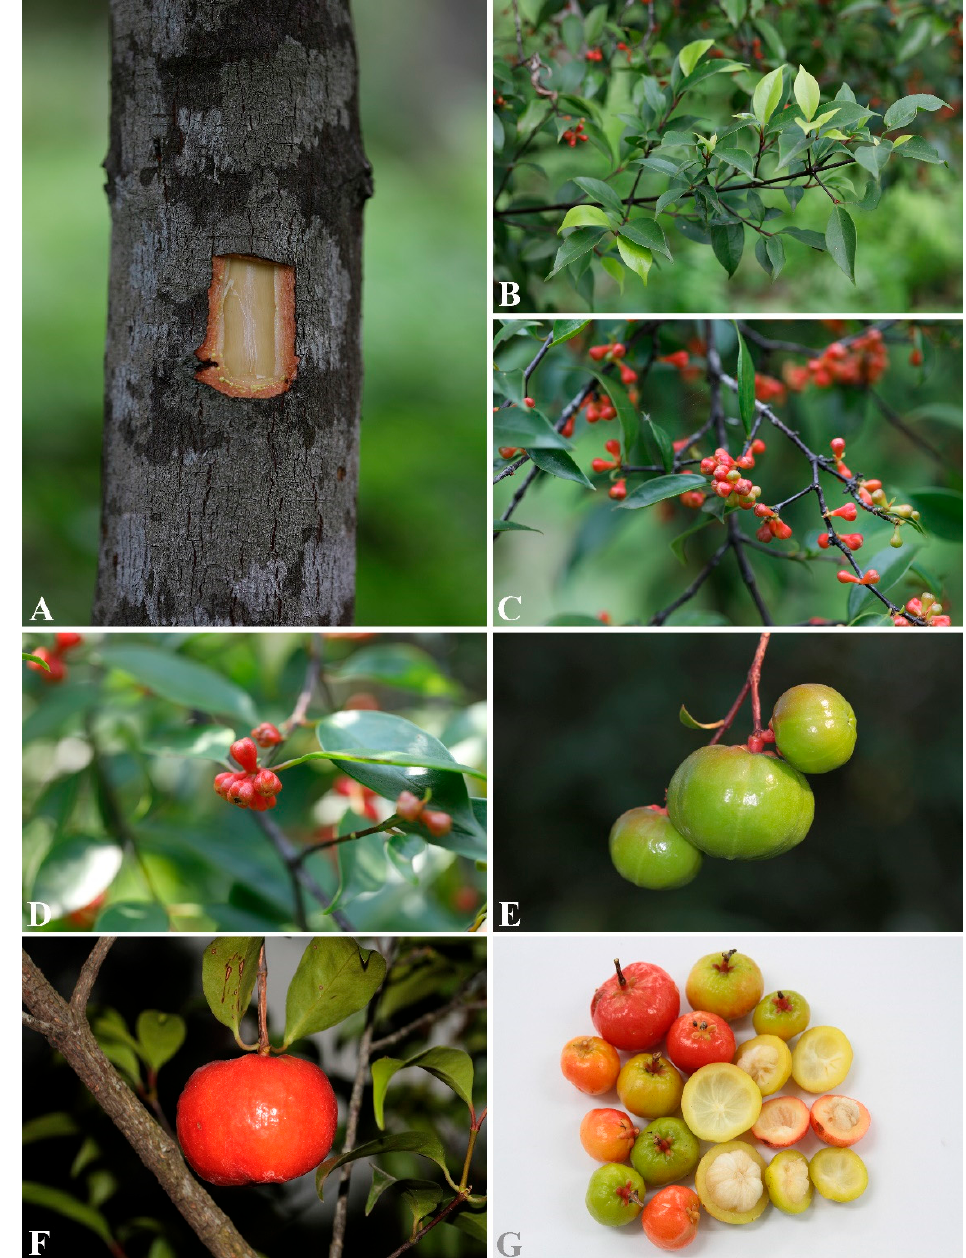
Figure 7. Garcinia lanceifolia : ( A ) stem, outer bark and inner bark with yellow latex; ( B ) branches, young and mature leaves; ( C ) male flowering branches; ( D ) inflorescence with female flowers; ( E ) fruiting branch; ( F ) ripe fruit; ( G ) mature and ripe fruits, showing pericarps and seeds with white sarcotesta (cross section). Photos: Chatchai Ngernsaengsaruay.